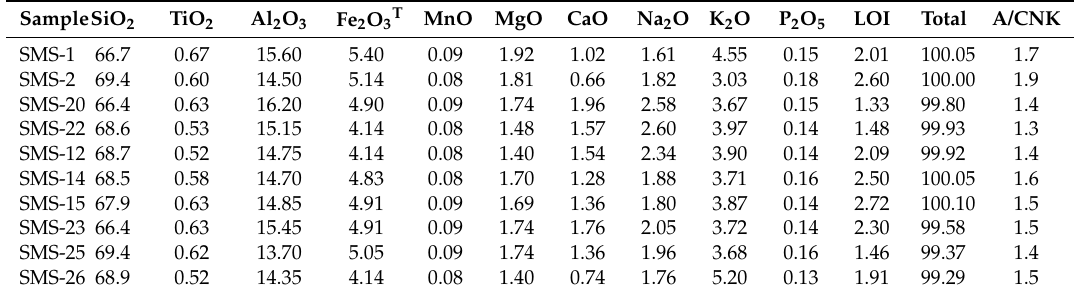
Figure 4. Harker diagrams for the Shimensi granodiorite. Data of the ore-related Mesozoic Shimensi granites are from Wei et al. [6]. Table 1. Major element contents of the Shimensi granodiorite (wt %).